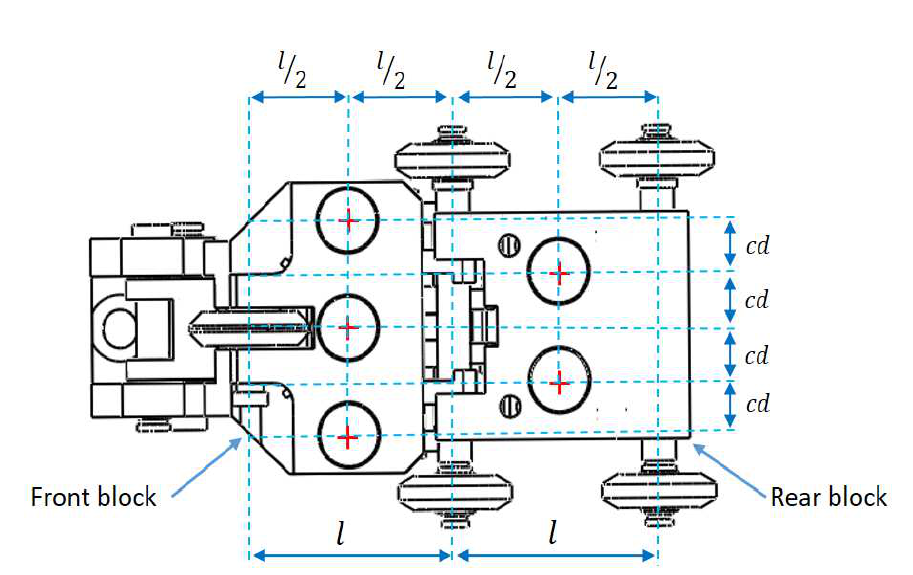
Figure 7. Distribution of ultrasound transducers in front and rear blocks.